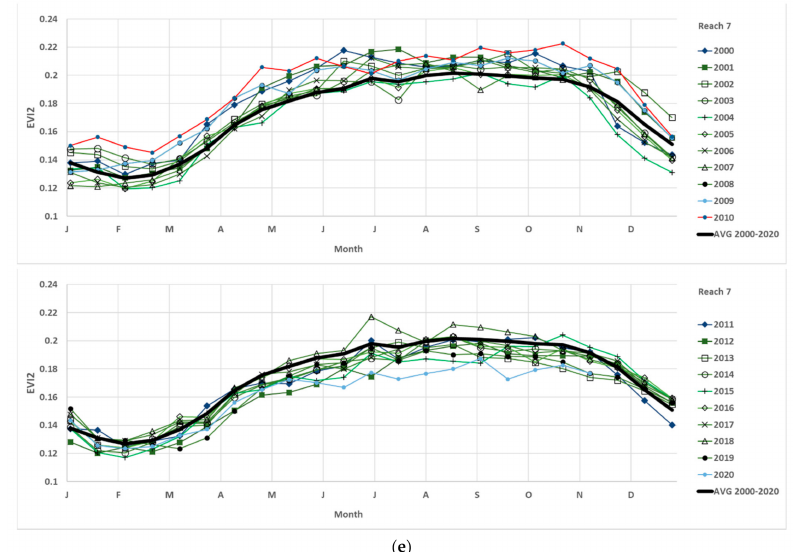
Figure 1. ( a – e ). EVI2 time-series information for the full 21-year period, 2000–2020, for the five reaches, R3 to R7 (Figure 1a–e), for the full year with months on the x -axis (J-D), and for individual years 2000–2010 ( top ) and 2011–2020 ( bottom